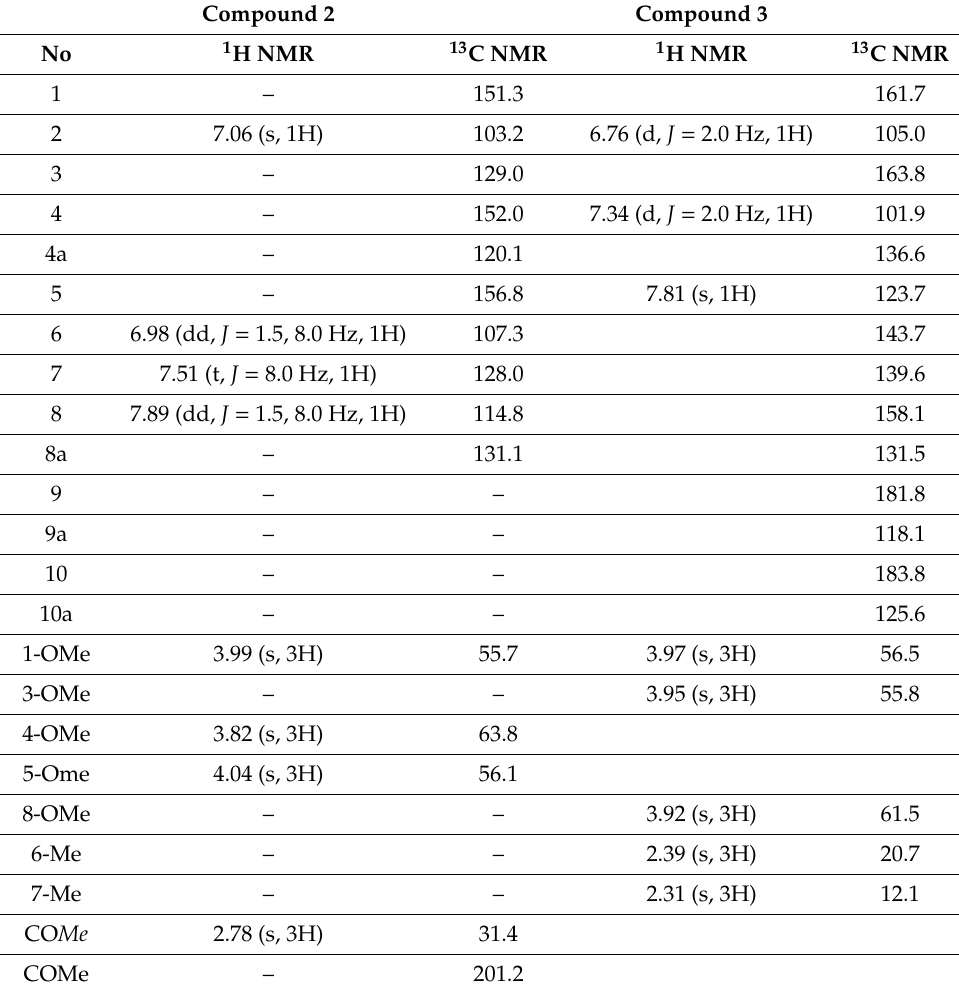
Table 2. 1 H NMR (400 MHz) and 13 C NMR (100 MHz) data of cichorins E ( 2 ) and F ( 3 ) in CDCl 3